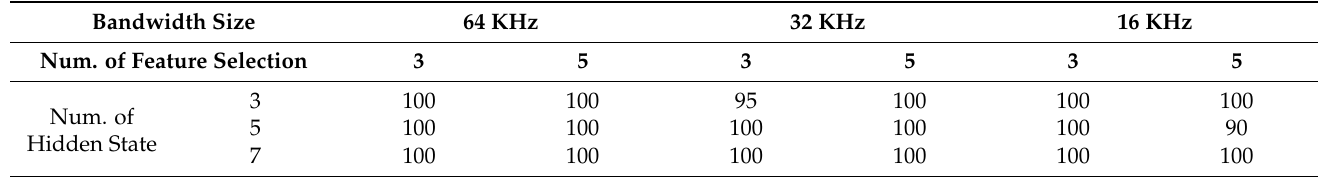
Table 6. Classification rate with AE signals on workpiece and 30 observation sequences. Unit